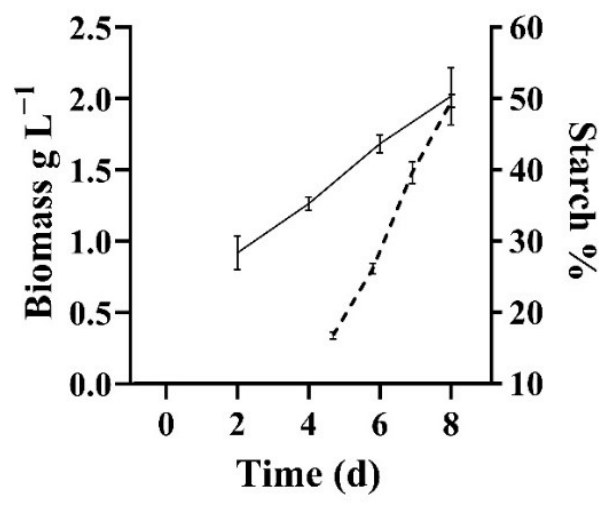
Figure 2. Time course of biomass growth and starch accumulation in T. chui cultivated in a 250 L tubular photobioreactor over 8 days. Biomass dry weight is expressed as g L − 1 (solid line) and starch accumulation is expressed as % of biomass dry weigh (dotted line). All data represent mean ± SD of triplicate measurements.